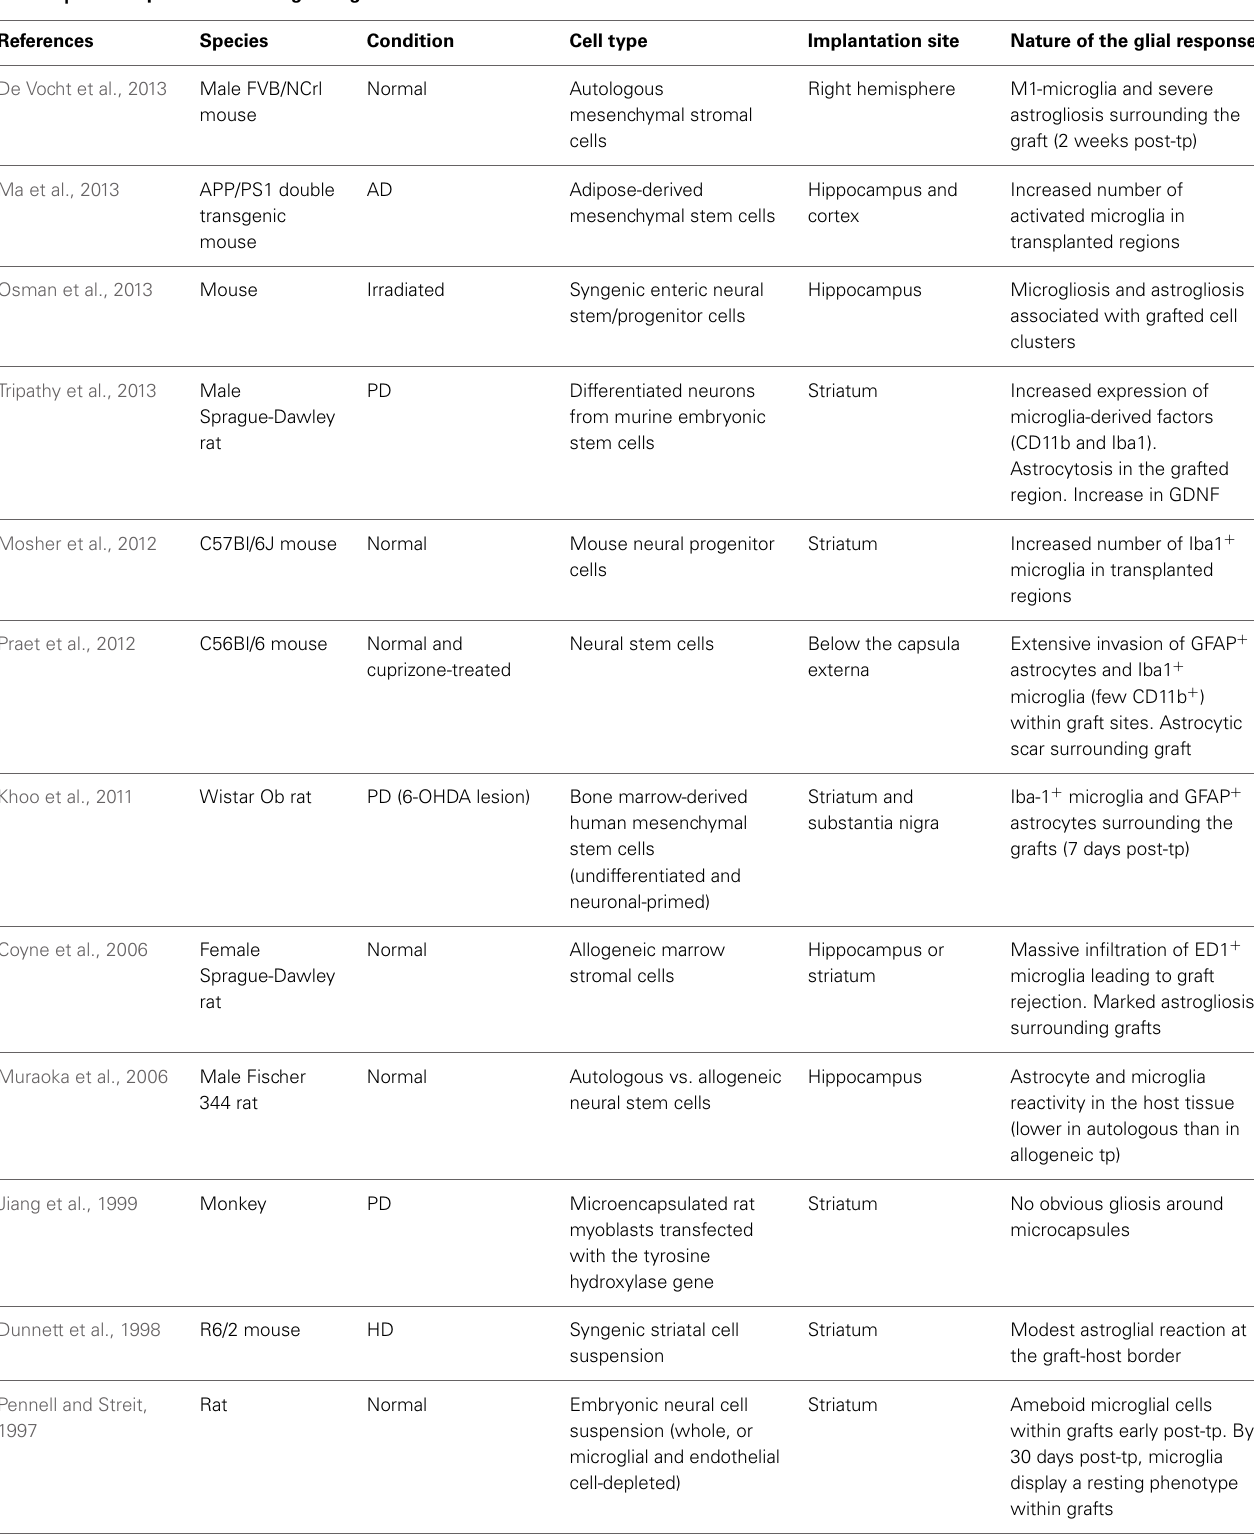
Table 3 | Glial response to neural grafting in in vivo